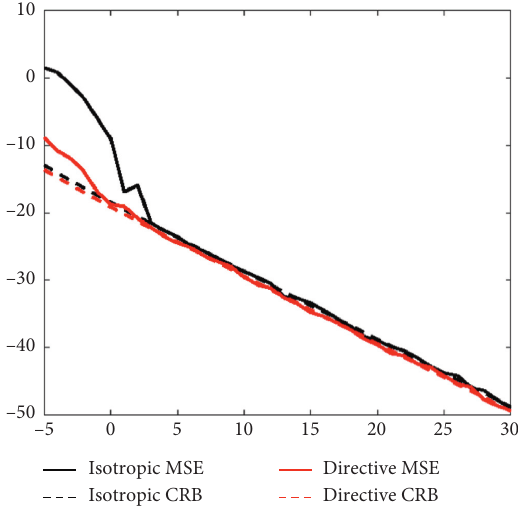
Figure 9: Full virtual array configuration.